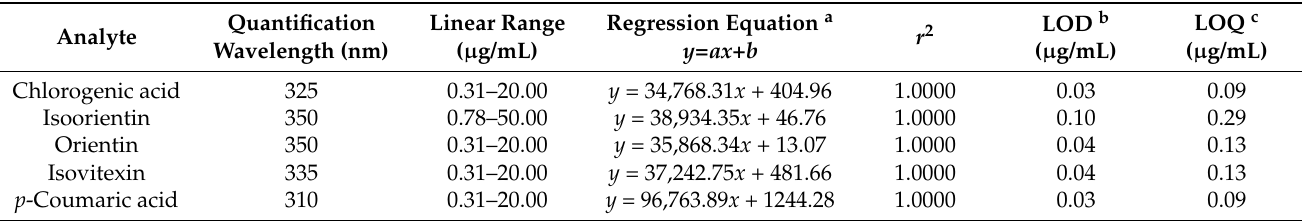
Table 1. Parameters for simultaneous HPLC analysis ( n = 3) of the five marker analytes in P. pubescens leaves